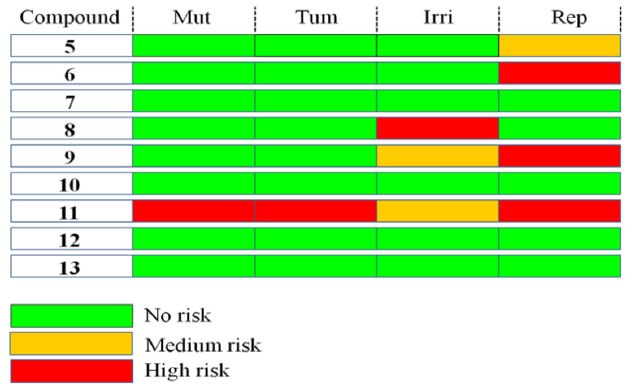
Figure 7. Computational Toxicity Risk plots of compounds 5 – 13 . Mut: Mutagenicity, Tum: Tumorigenicity, Irri: Irritation, Rep: Reproductive or developmental toxicity.